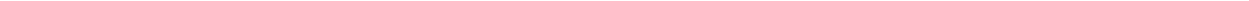
Fig. 4 Genome-wide HJAY and iTRAQ LC – MS/MS identify new CELF1-regulated targets. a Differentially expressed (DE) and alternatively spliced (AS) genes identi fi ed by HJAY in SK-Mel-103 or UACC-62 cells transduced with shCELF1-1 estimated with respect to shRNA controls. The speci fi c overlap in the mRNA expression changes is shown in Supplementary Fig. 7c, d. b Splicing alterations identi fi ed by the HJAY in SK-Mel-103 and UACC-62 upon CELF1 depletion. c Overlap (%) in changes in mRNA expression after depletion of CELF1 in melanoma cells (SK-Mel-103 and UACC-62) with respect to similar transcriptomic data available for K562 leukemia and HepG2 hepatoma cell lines (ENCODE ENCSR605MFS and ENCSR695XOD, respectively). The diameter of the Venn diagrams is proportional to the genes with mRNA changes in each data set. d Up- and downregulated proteins identi fi ed by iTRAQ LC – MS/MS analyses in SK-Mel-103 or UACC-62 cells upon shCELF1-1 transduction estimated with respect to shRNA controls. Up- and downregulated proteins (red and green, respectively) are shown as volcano plots. Factors indicated in green and red are those with signi fi cant changes in protein expression. Non signi fi cant changes in expression are labeled in gray (additional information for the relative overlap in the iTRAQ data for the cell lines analyzed is summarized in Supplementary Fig. 7e, f). e Correlation of global changes in RNA and protein levels upon CELF1 depletion in SK-Mel-103 and UACC-62 melanoma cell lines. f Heatmap of gene sets found enriched (Reactome pathway database) both at RNA and protein levels in shCELF1-1 expressing melanoma cells, listed as a function of FDR values. g Top-10 downregulated cellular functions identi fi ed in the two cell lines analyzed. Listed are enriched gene sets, the total number of genes in each category, the number of genes deregulated in both cell lines, and the range of FDR values ( < 0.25). h Expression levels of representative modulators of cell cycle and/or DNA replication upon CELF1 depletion in UACC-62 cells, as validation of data obtained from HJAY. Error bars correspond to SEM of three experiments in